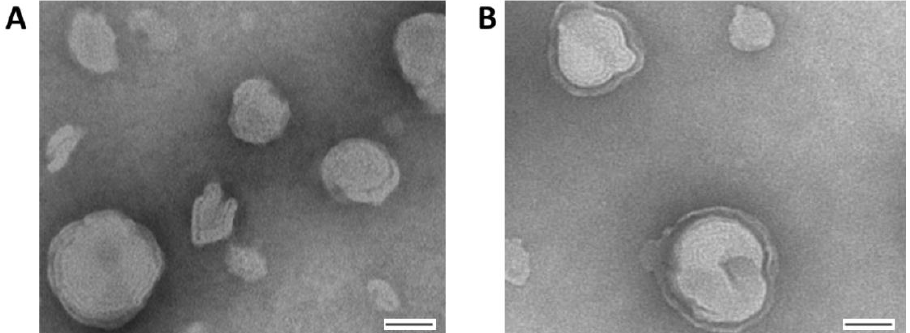
Figure 2. Transmission electron micrographs (TEM) of the cationic liposome. Solutions of the cationic liposome (0.5 µg/uL in ddH 2 O) were analyzed after incubation at room temperature for ( A ) 24 h, or ( B ) 2 weeks. The preparation was negatively stained with 3% phosphotungstic acid and imaging performed at 75 kV. Bar = 100 nm.